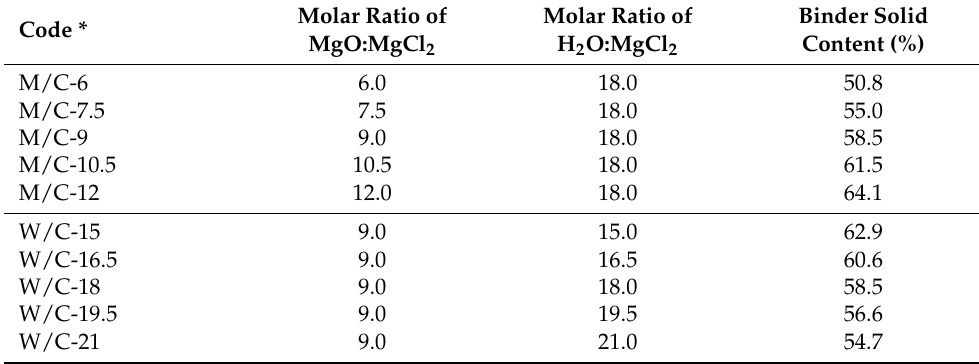
Table 3. Mixture composition of MOC